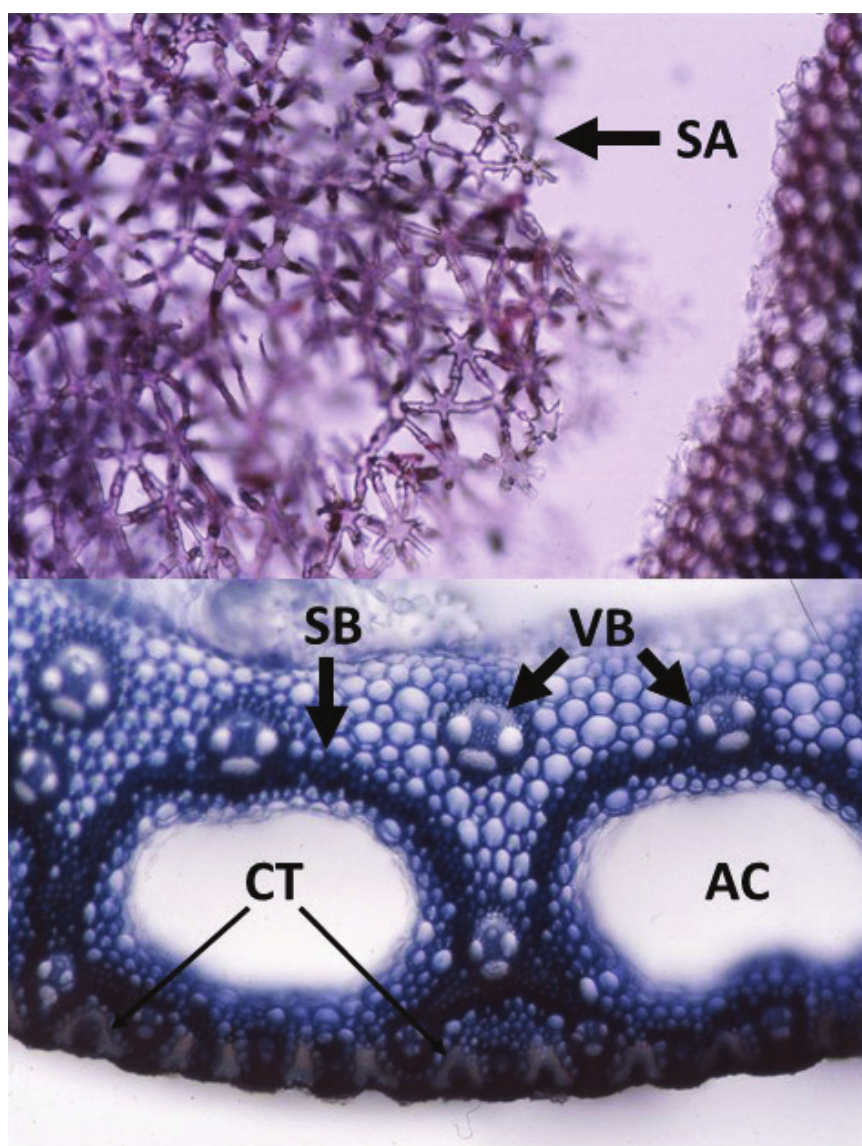
Figure 10. Stem anatomy of Diplachne gigantea. Upper: Stellate aerenchyma ( SA ) that occupies much of the central portion of the culm (voucher: Smith 4126 [MO]). Lower: Outer portion of stem showing air canals ( AC ), chlorenchymatous tissue ( CT ), vascular bundles ( VB ), and scle- renchyma bands ( SB ) surrounding the air canals (voucher: Simon & Williamson 2025 [BM]). from which he had collected were small. He confirmed, as some herbarium specimens labels and the stellate culm anatomy suggest, that the species is an emergent aquatic that can continue to grow on